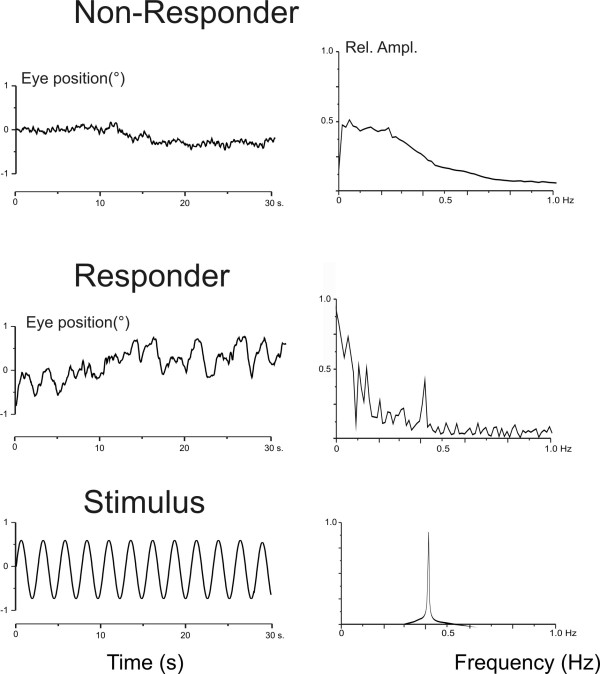
Oculomotor response and spectral analysis. Left: Original recordings of oculomotor response in two patients together with the sine wave stimulus (first column). Right: Corresponding frequency spectra of the oculomotor response and stimulus. The first patient failed to show an oculomotor response, that is, no response during Galvanic labyrinth polarization stimulation. The Glasgow Outcome Score after six months was 1. The second patient showed an oculomotor response to Galvanic labyrinth polarization stimulation: The frequency spectrum reflects the oculomotor response component the stimulus frequecy (0.41 Hz) in synchrony with the Galvanic labyrinth polarization stimulus. This patient survived with an Glasgow Outcome Score of 4.